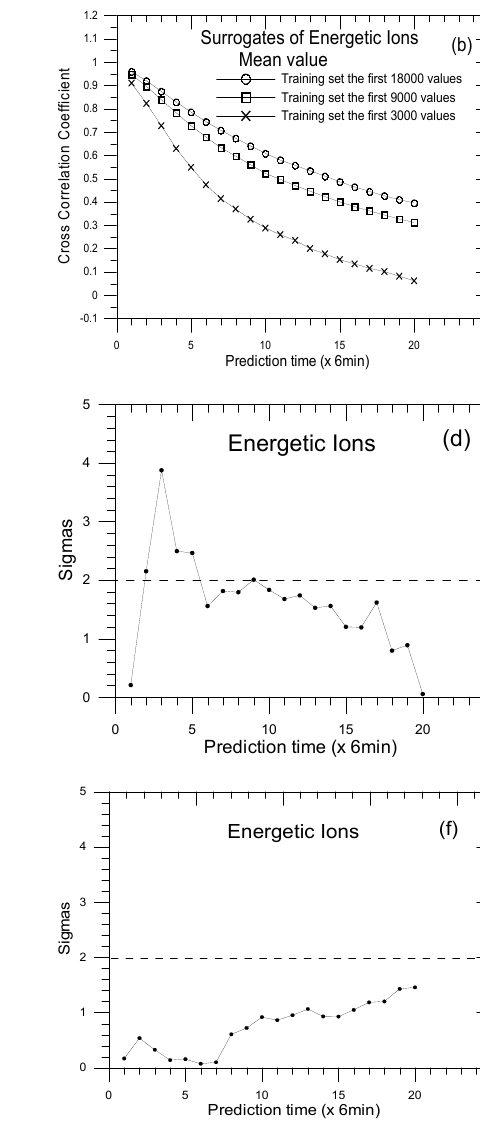
Fig. 8. (a) Correlation coefficient between predicted and real values for the energetic ions’ time series as a function of prediction time, increasing the width of the training set, estimated for embedding dimension m = 6, delay time τ = 30 and k = 16 neighbours. (b) The same with (a) but for the mean value of 40 surrogate data sets. (c) The absolute difference between the correlation coefficients corresponding to training set of 3000 and 18000 data points for the energetic ions’ time series and its surrogate data. (d) Significance of statistics shown in Fig. 8c. (e) Figure 8e is similar to Fig. 8c but for training set the first 3000 and 9000 data points. (f) Significance of the statistic shown in Fig.